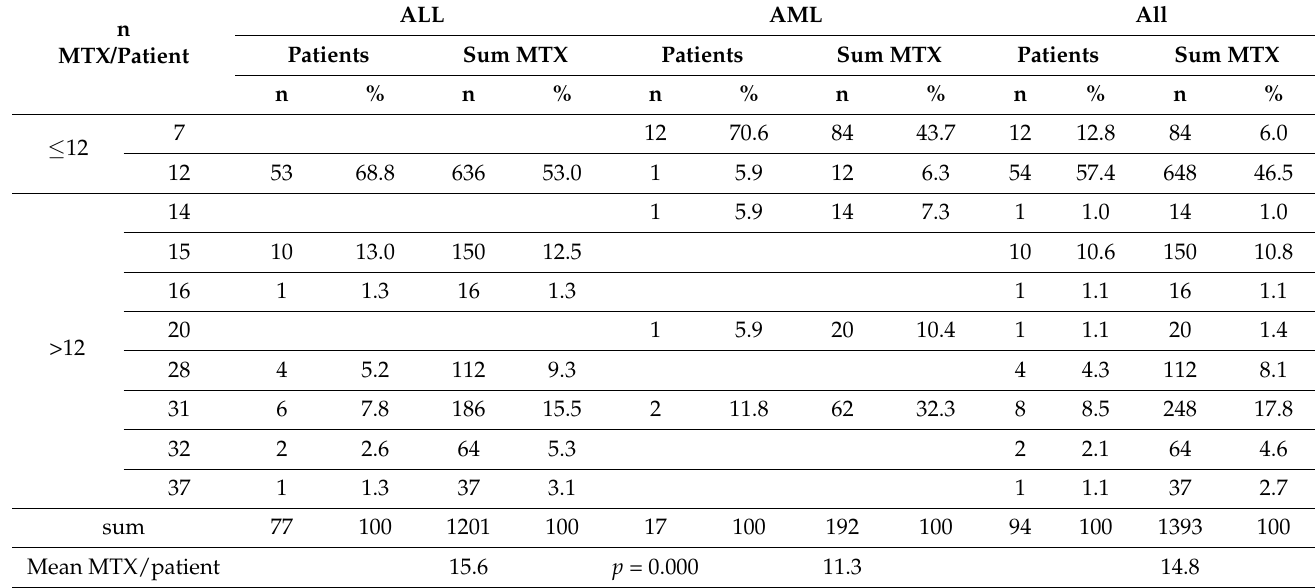
Table 2. Number of ith. MTX applications ( ≤ 12 vs. >12) in patients with ALL and their correlation to risk factors and morphological changes in cMRI. (SCT: hematopoietic stem cell transplantation).